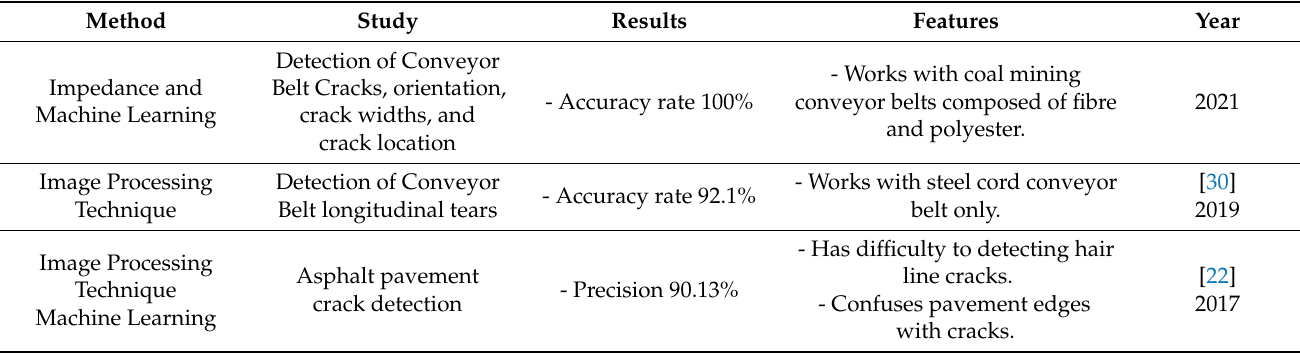
Table 9. Performance